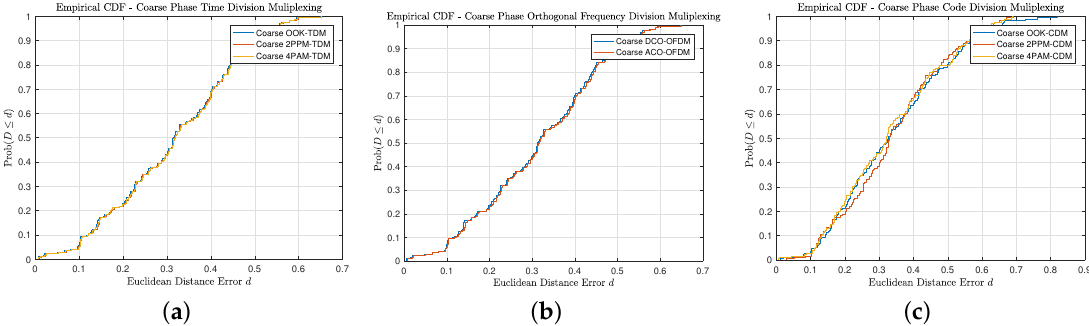
Figure 11. Model Description: ( a ) Empirical CDF of Euclidean Distance Error for Time Division Multiplexing using Coarse Phase Proximity Positioning; ( b ) Empirical CDF of Euclidean Distance Error for Orthogonal Frequency Division Multiplexing using Coarse Phase Proximity Positioning; ( c ) Empirical CDF of Euclidean Distance Error for Code Division Multiplexing using Coarse Phase Proximity Positioning.